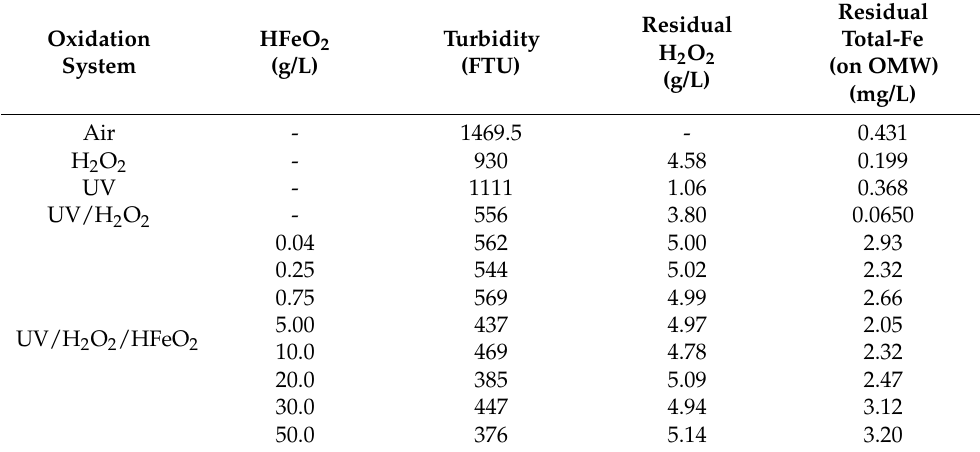
Table 2. Final values of parameter (turbidity, residual oxidant agent, and total iron) determined for treated water at the end of the experiments and after sample